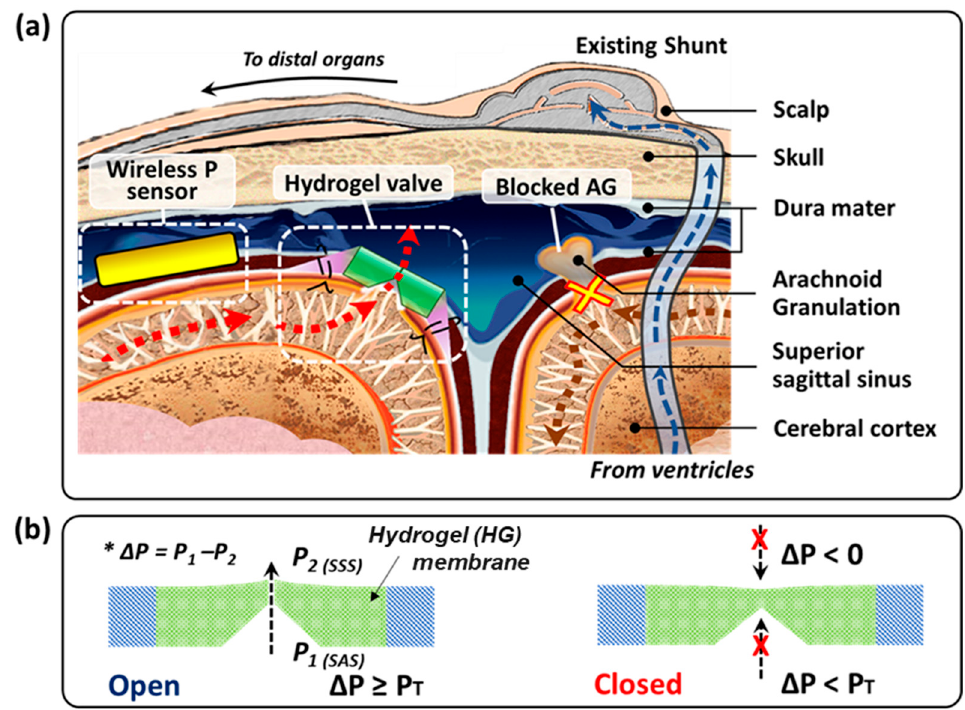
Figure 1. ( a ) Illustration of alternative cerebrospinal fluid (CSF) draining methods (existing shunt system and hydrogel valve of this work) for hydrocephalus treatment. Existing shunts include catheters connected from the brain ventricles to distal body spaces in order to drain CSF outwards. The proposed hydrogel valve is implanted directly in the intradural space of the superior sagittal sinus and directs CSF drainage from the subarachnoid space (SAS) into the superior sagittal sinus (SSS). This method of directing CSF allows the CSF draining process to be confined within the cranium without the use of catheters that cause many complications. ( b ) Basic operation of the valve at a cross-sectional view. When the hydrogel becomes hydrated, the swollen hydrogel structure closes the hole, forming the closed valve. When the pressure in the SAS reaches higher than the SSS over the threshold, namely, cracking pressure (P T ), Δ P > P T , the swollen hydrogel valve becomes open and CSF can flow unidirectionally from SAS to SSS. When the SAS has lower pressure than the SSS by less than a differential threshold, P T , Δ P < P T , the valve is closed and blocks the CSF flow as the pressure difference cannot open the valve.